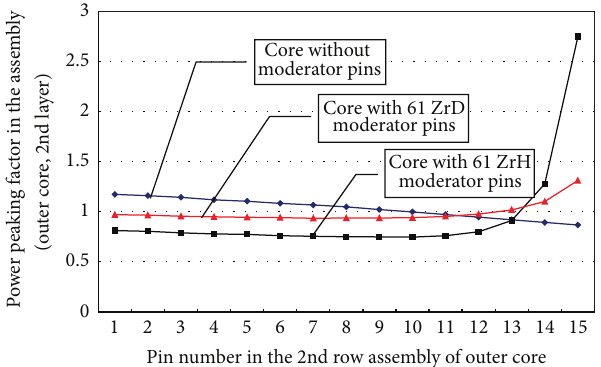
Figure 2: Core arrangement of MONJU.